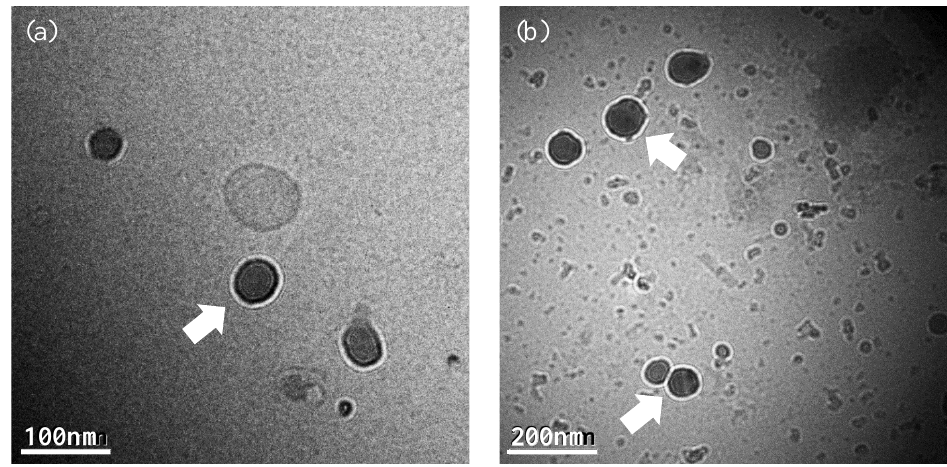
Figure 6. TEM images of nanoparticles. ( a ) Sol/ASC-DP = 9/1, ( b ) Sol/ASC-DP = 8/2.